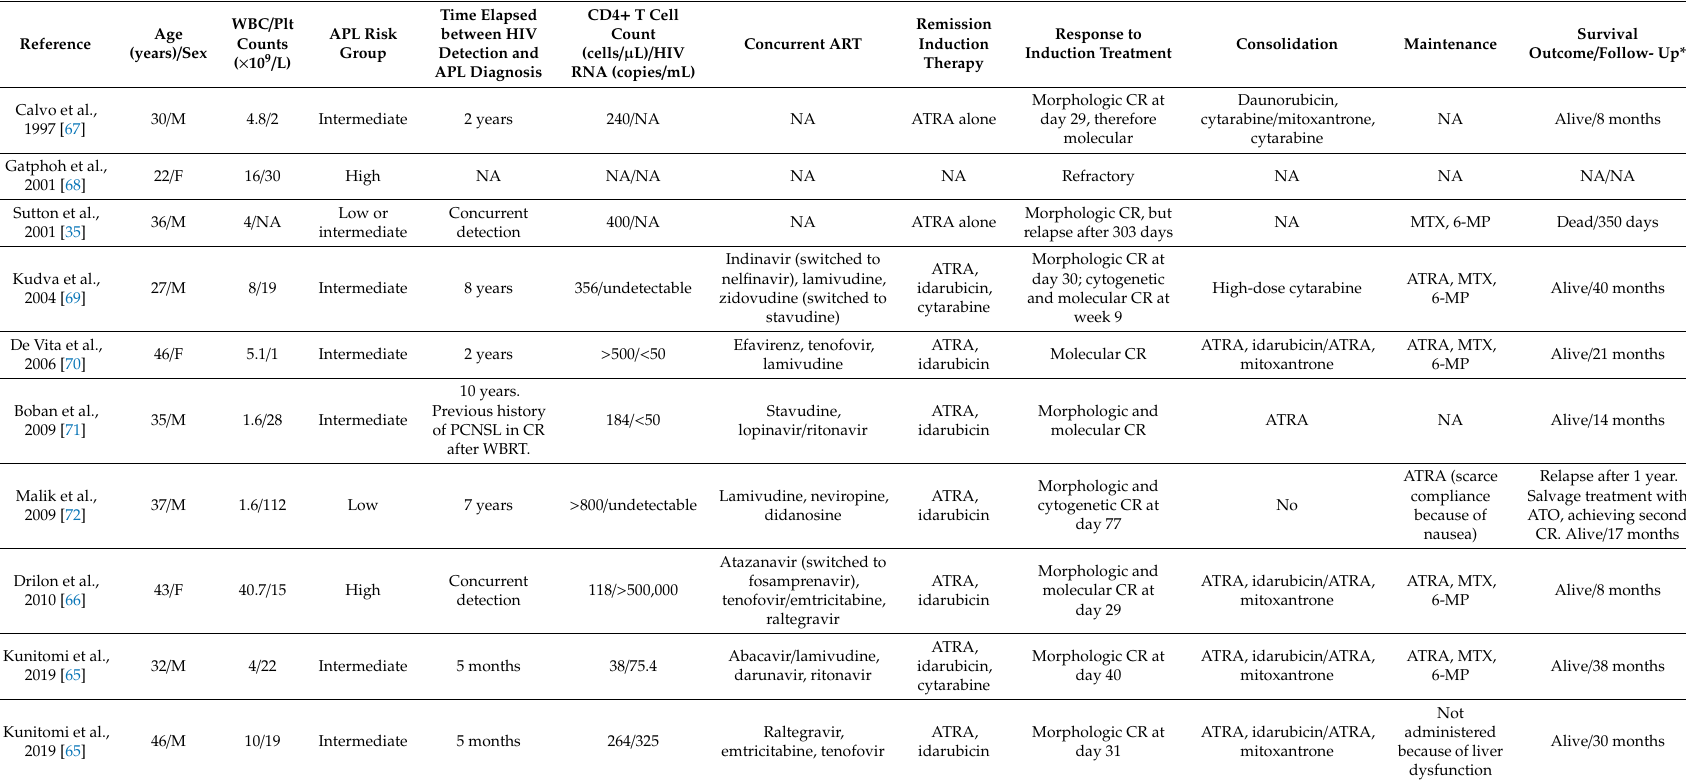
Table 3. Acute promyelocytic leukemia (APL) in patients with HIV infection: review of detailed cases reported in the